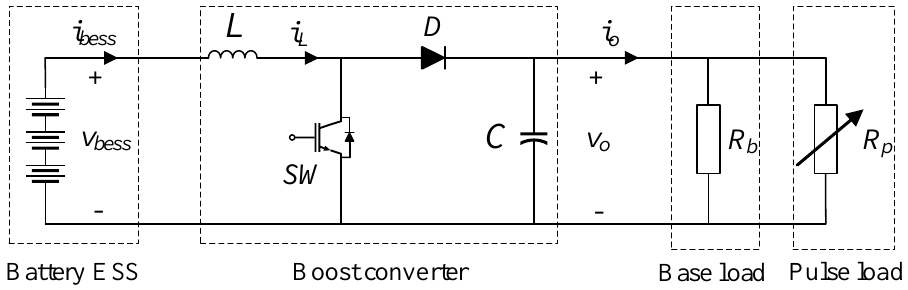
Figure 1. Simplified equivalent circuit of the simulated system.